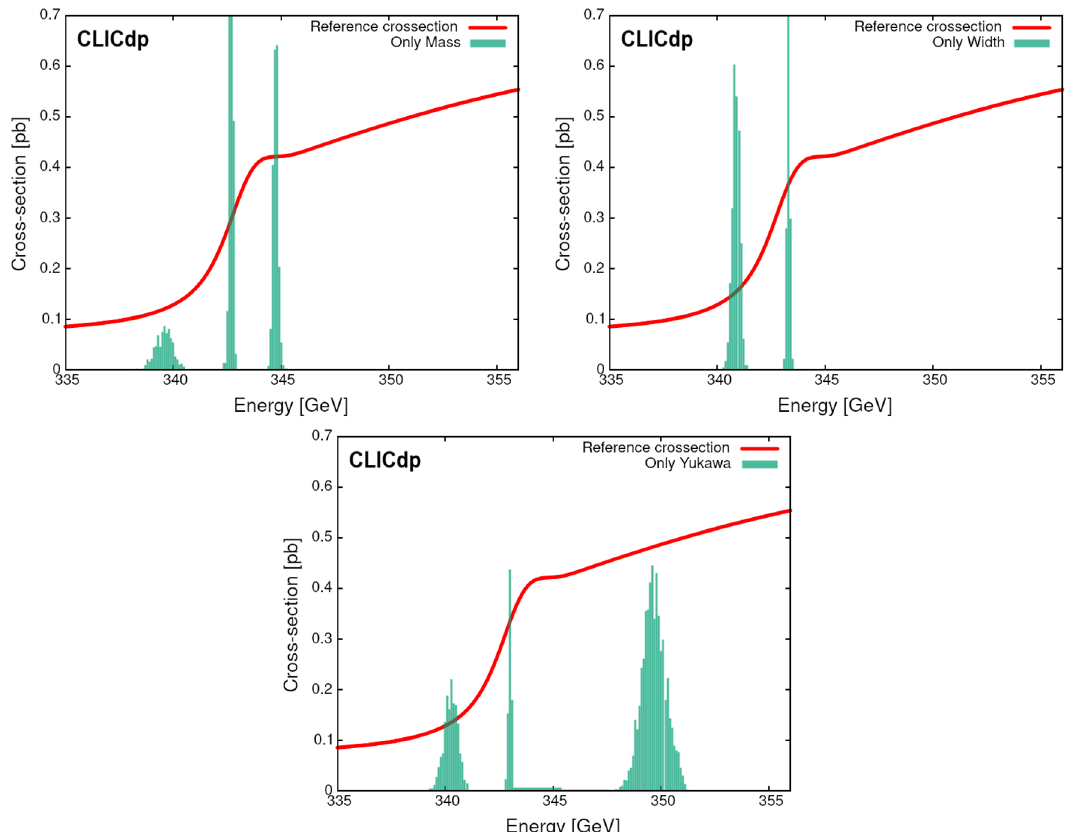
Figure 10 . Distribution of the measurement points from last generation (arbitrary scale) com- pared with the reference cross section template, for three single parameter optimisation scenarios: top-quak mass (top left), top-quark width (top right) and top Yukawa coupling (bottom plot) mea- surement